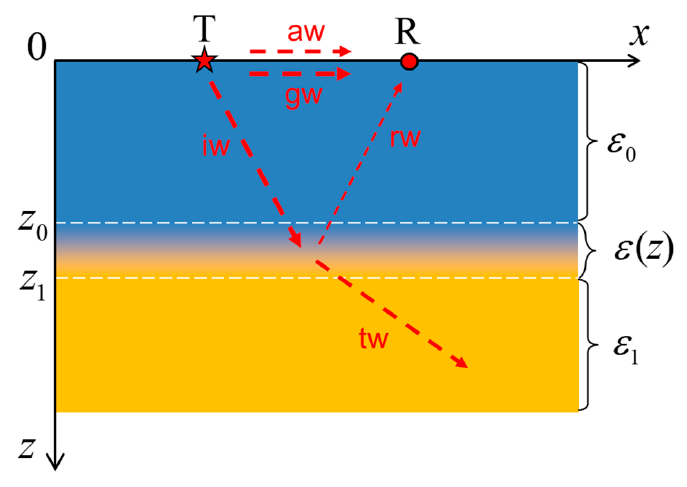
Figure 4. Geometry of the simulated scenario and schematic representation of the radar signal components.